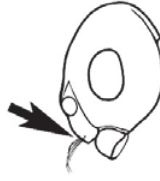
In profile, clypeal psammophore in minor worker placed just behind anterior clypeal margin and well below midpoint of clypeus in major worker; eye in most specimens large (eye length 0.20 to 0.25 × length of side of head cap- sule in major worker, 0.33 to 0.50 × length of side of head capsule in minor worker); propodeum in major worker narrow with an oblique dorsal face; shining brown with gaster slightly darker (NSW, WA) (Fig. 64a–g) .... major